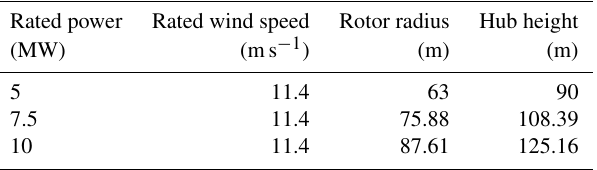
Table 1. Summary information for the three turbine models utilised in the current